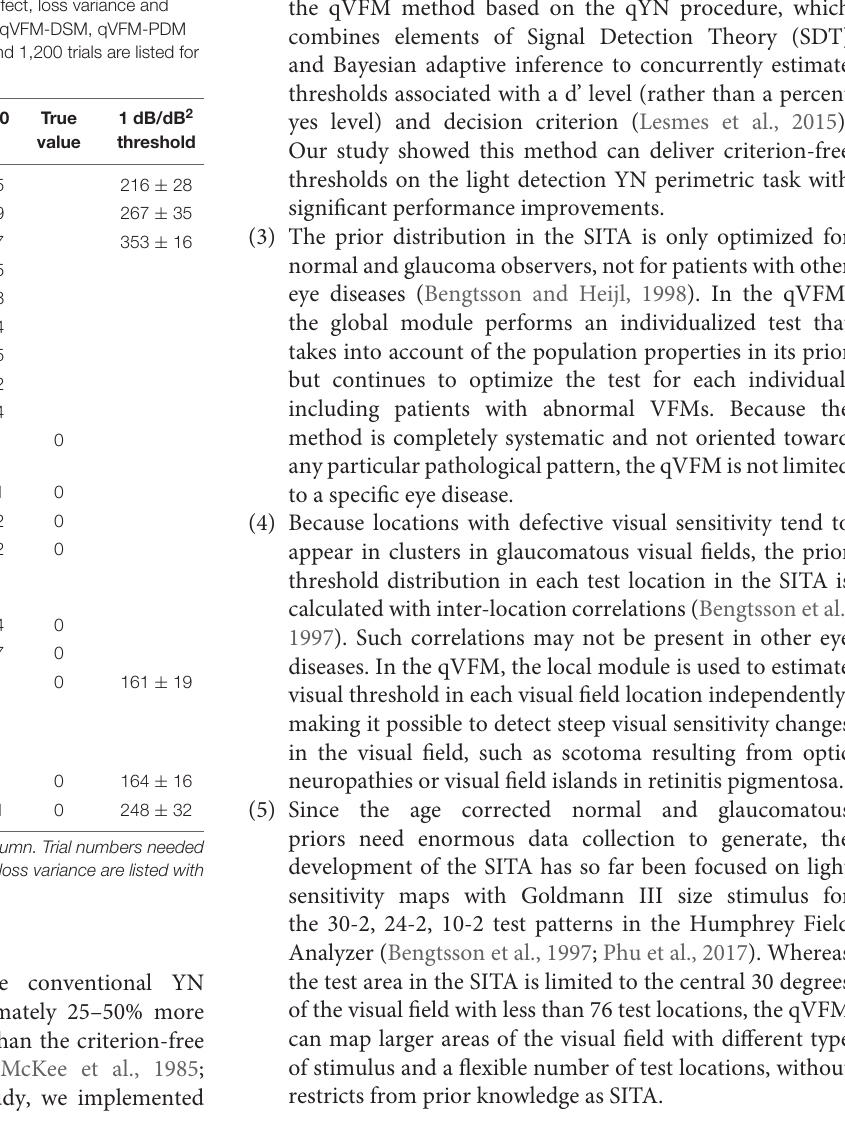
TABLE 6 | RMSE, SD, average 68.2% HWCI, mean defect, loss variance and corrected loss variance of the estimated VFM from the qVFM-DSM, qVFM-PDM and qYN methods in the beginning (0 trial), after 300 and 1,200 trials are listed for the simulated normal observer. Normal